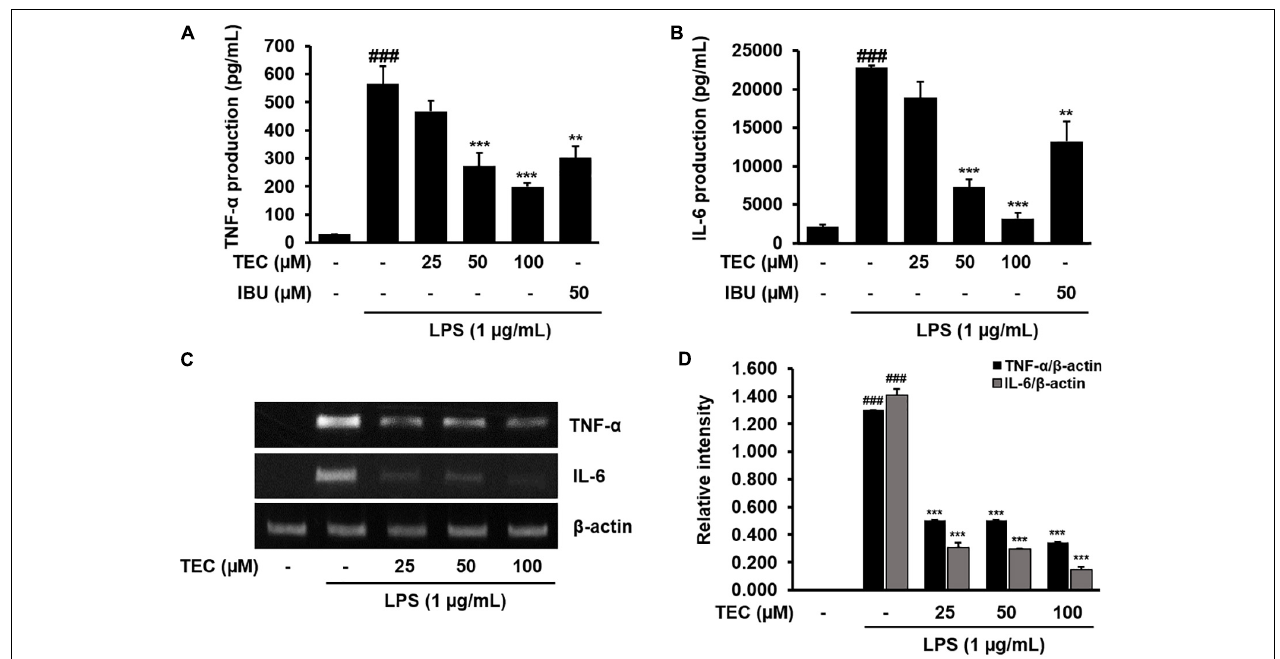
FIGURE 3 | TEC inhibits the production expression of inflammatory cytokines in LPS-stimulated BV-2 microglia. Cells were pre-treated with TEC for 2 h followed by LPS stimulation (1 µ g/mL) for 22 h. The supernatants are obtained and the amount of (A) TNF- α and (B) IL-6 released into the media is determined. (C) Cells were pretreated with TEC for 1 h followed by LPS stimulation for 5 h and then RT-PCR are performed to see the effects of TEC on mRNA expression of TNF- α and IL-6. (D) Bar graphs represent the relative expression of TNF- α and IL-6 for (C) . Ibuprofen (50 µ M) was used as a positive control. The results are expressed as the mean ± SEM of three independent experiments. ### P < 0.001 vs. untreated control cells and ∗∗ P < 0.01 or ∗∗∗ P < 0.001 vs. LPS-treated